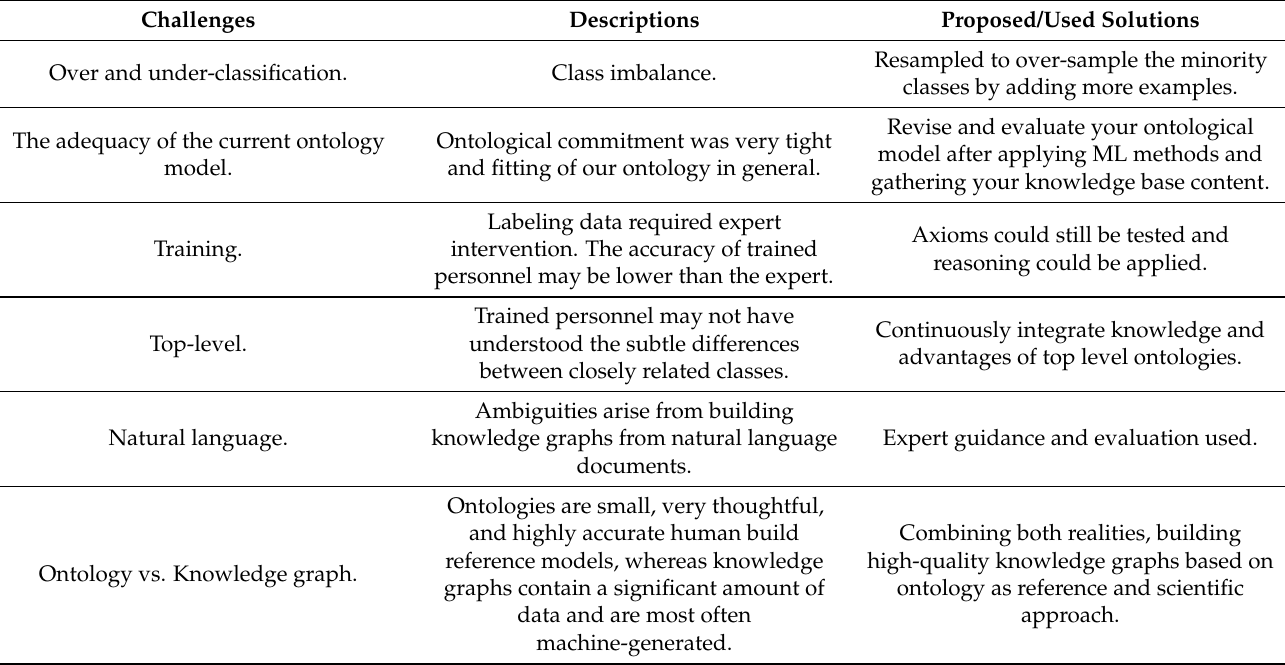
Table 10. Summary of